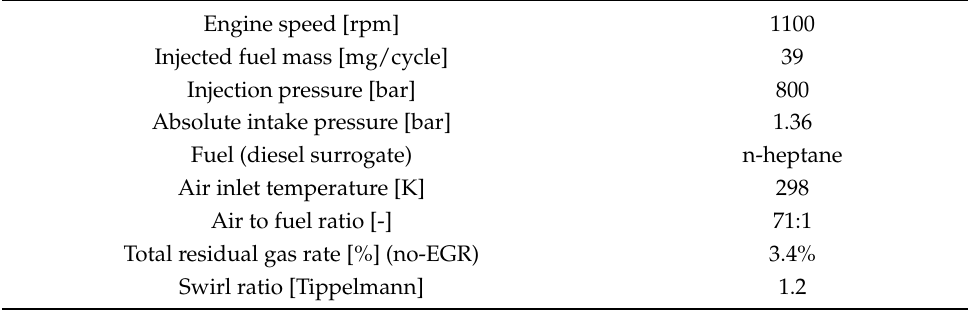
Table 2. Engine operating